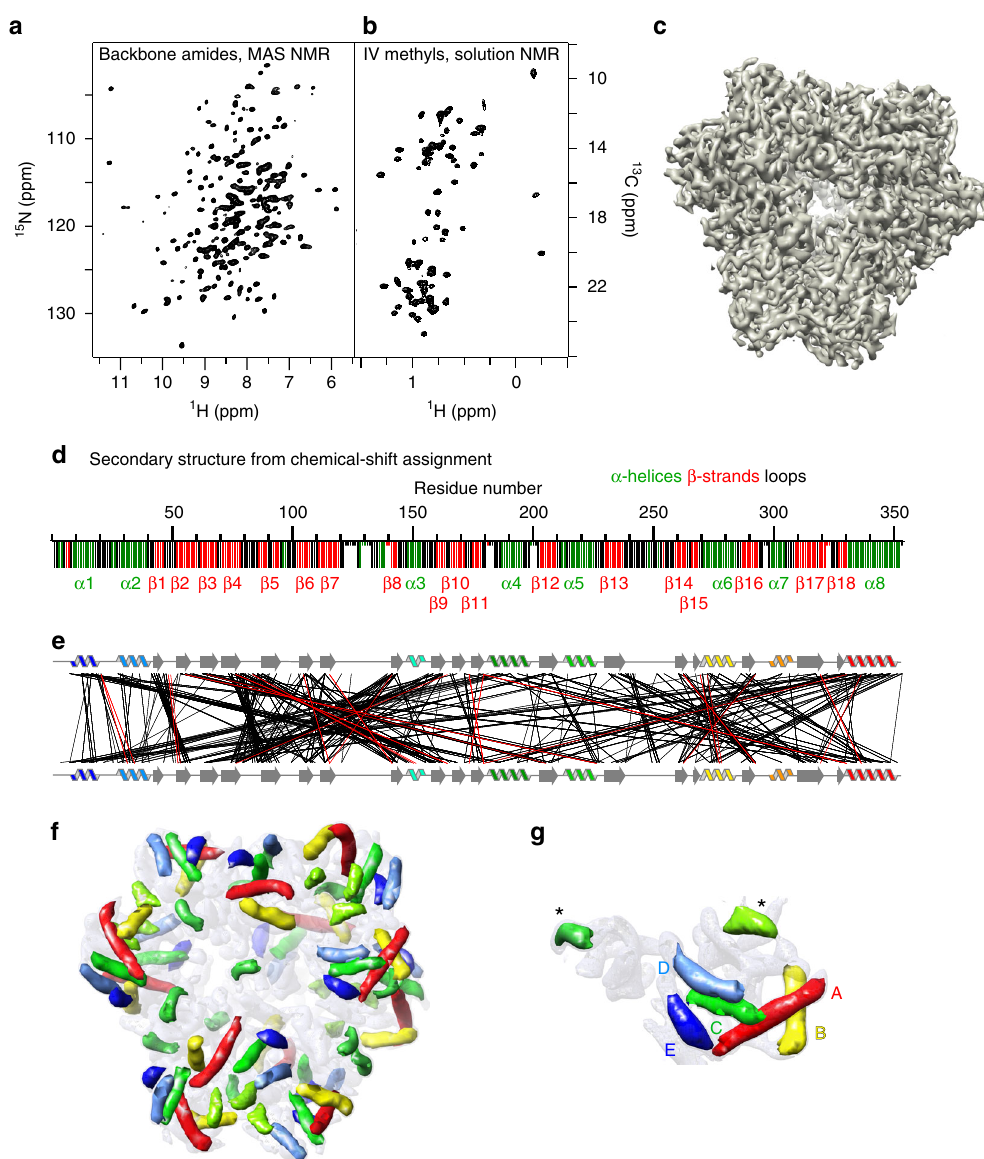
Fig. 1 Experimental NMR and EM data of the 468 kDa TET2 assembly. a MAS NMR and b solution-NMR spectra of TET2, showing high resolution despite the large subunit size. c Experimental 4.1 Å resolution cryo-EM electron-density map. d Secondary structure of TET2, derived from MAS NMR resonance assignments and the TALOS-N software 20 , shown as a function of the residue number. Residues shown with shorter bars were not assigned, and the secondary structure assignment results from a database approach in TALOS-N. e Experimentally detected intra-subunit long-range distance restraints from solution-NMR and MAS NMR, displayed through lines connecting residues in close spatial proximity. Note that part of these distance restraints were spectrally ambiguous, i.e., could be assigned to several atom-atom pairs, and was rendered unambiguous throughout the structure calculation approach (displayed in red). See Table 1 for restraints statistics. All NMR experiments performed in this study and acquisition parameters are listed in Supplementary Tables 2 – 5. f α -Helices detected by the helixhunter2 software 25,50 in the EM map truncated to 8 Å resolution. Symmetry-related α -helices are shown in equal colors. Additional β -sheet parts, automatically detected by gorgon 51 are shown in Supplementary Fig. 8A. g Zoom on one subunit, identi fi ed by a clustering analysis (Supplementary Fig. 8). The fi ve longest α -helices, used for the initial structure calculation steps are labeled with A to E in order of decreasing length (see Table